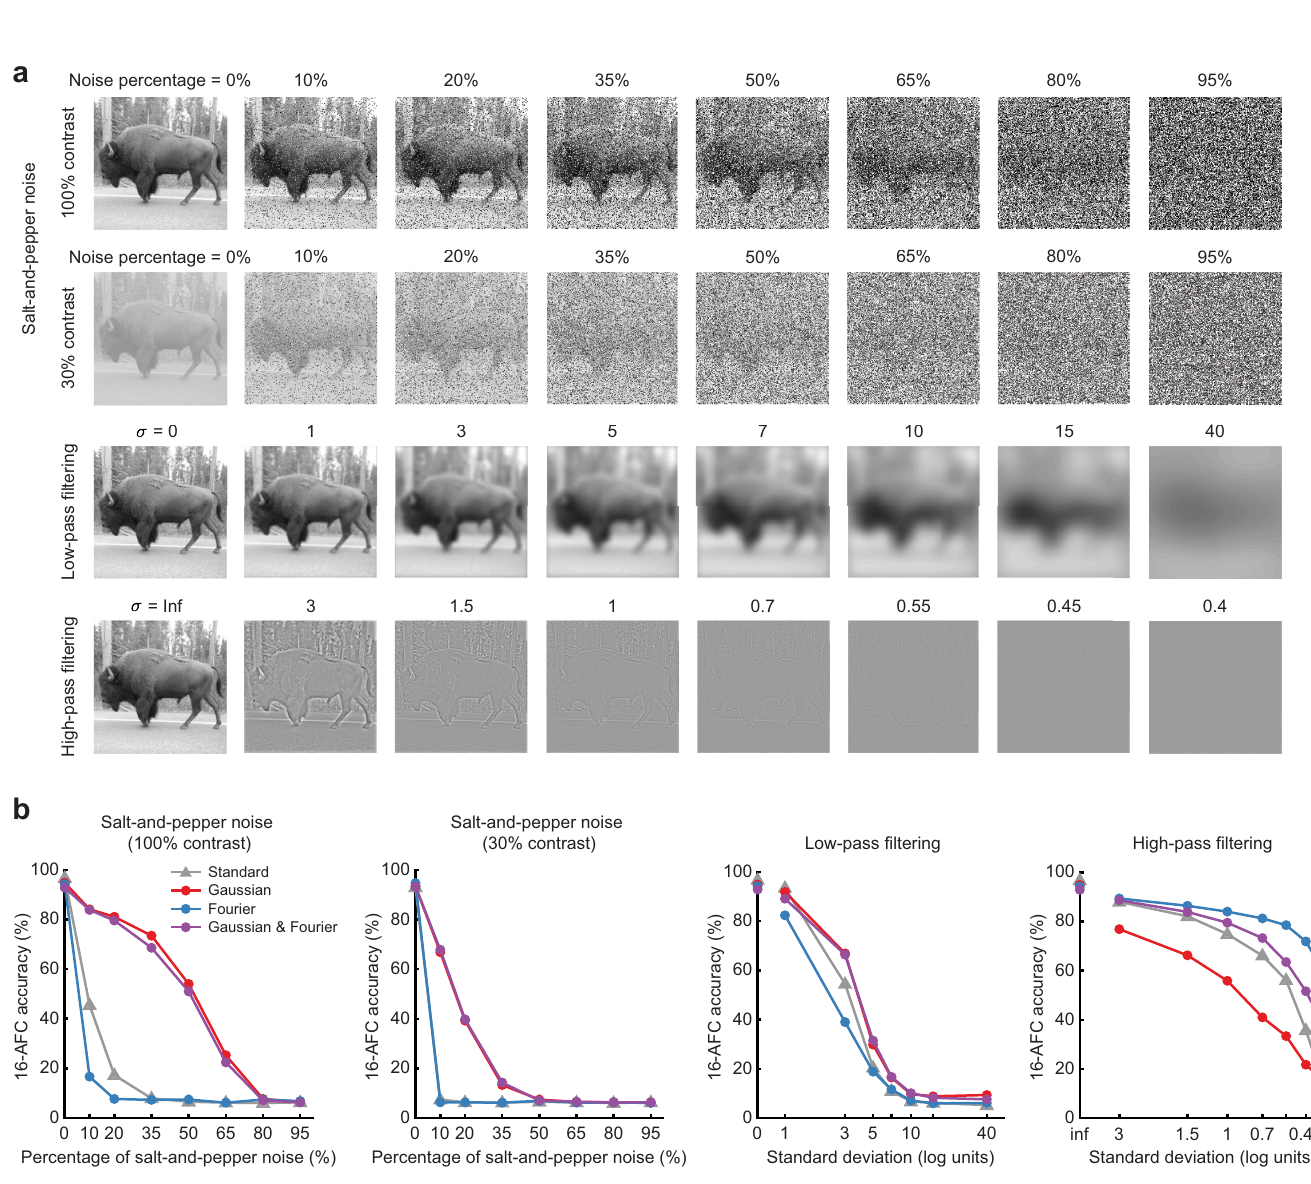
Fig 8. Noise-trained DNNs can partly generalize to other image distortions. (a) Examples of images used to test the impact of salt-and-pepper noise, low-pass filtering, and high-pass filtering on DNN performance. Image manipulations followed the methods described in [29]. Bison image by Frank Tong . (b) Performance accuracy of standard and noise-trained versions of VGG-19 at recognizing images with different types and levels of image distortion. The noise-trained DNNs were trained with either Gaussian noise (0.2 SSNR), Fourier phase-scrambled noise (0.2 SSNR), or both noise types combined, in addition to noise-free images. Data are available at https://osf.io/bxr2v/. DNN, deep neural network; SSNR, signal-to-signal-plus-noise ratio. object images corrupted by salt-and-pepper noise, outperforming standard pretrained DNNs. By contrast, the DNN trained with Fourier phase-scrambled noise showed better performance at recognizing high-pass filtered images than the standard DNN, but with some cost in perfor- mance for low-pass filtered images. The DNN trained on both types of noise showed a similar improvement at recognizing high-pass filtered images, with no associated cost in recognizing low-pass filtered images. Thus, in contrast to earlier reports, we find that DNNs trained with noisy object images can generalize to other types of image distortions to some extent.